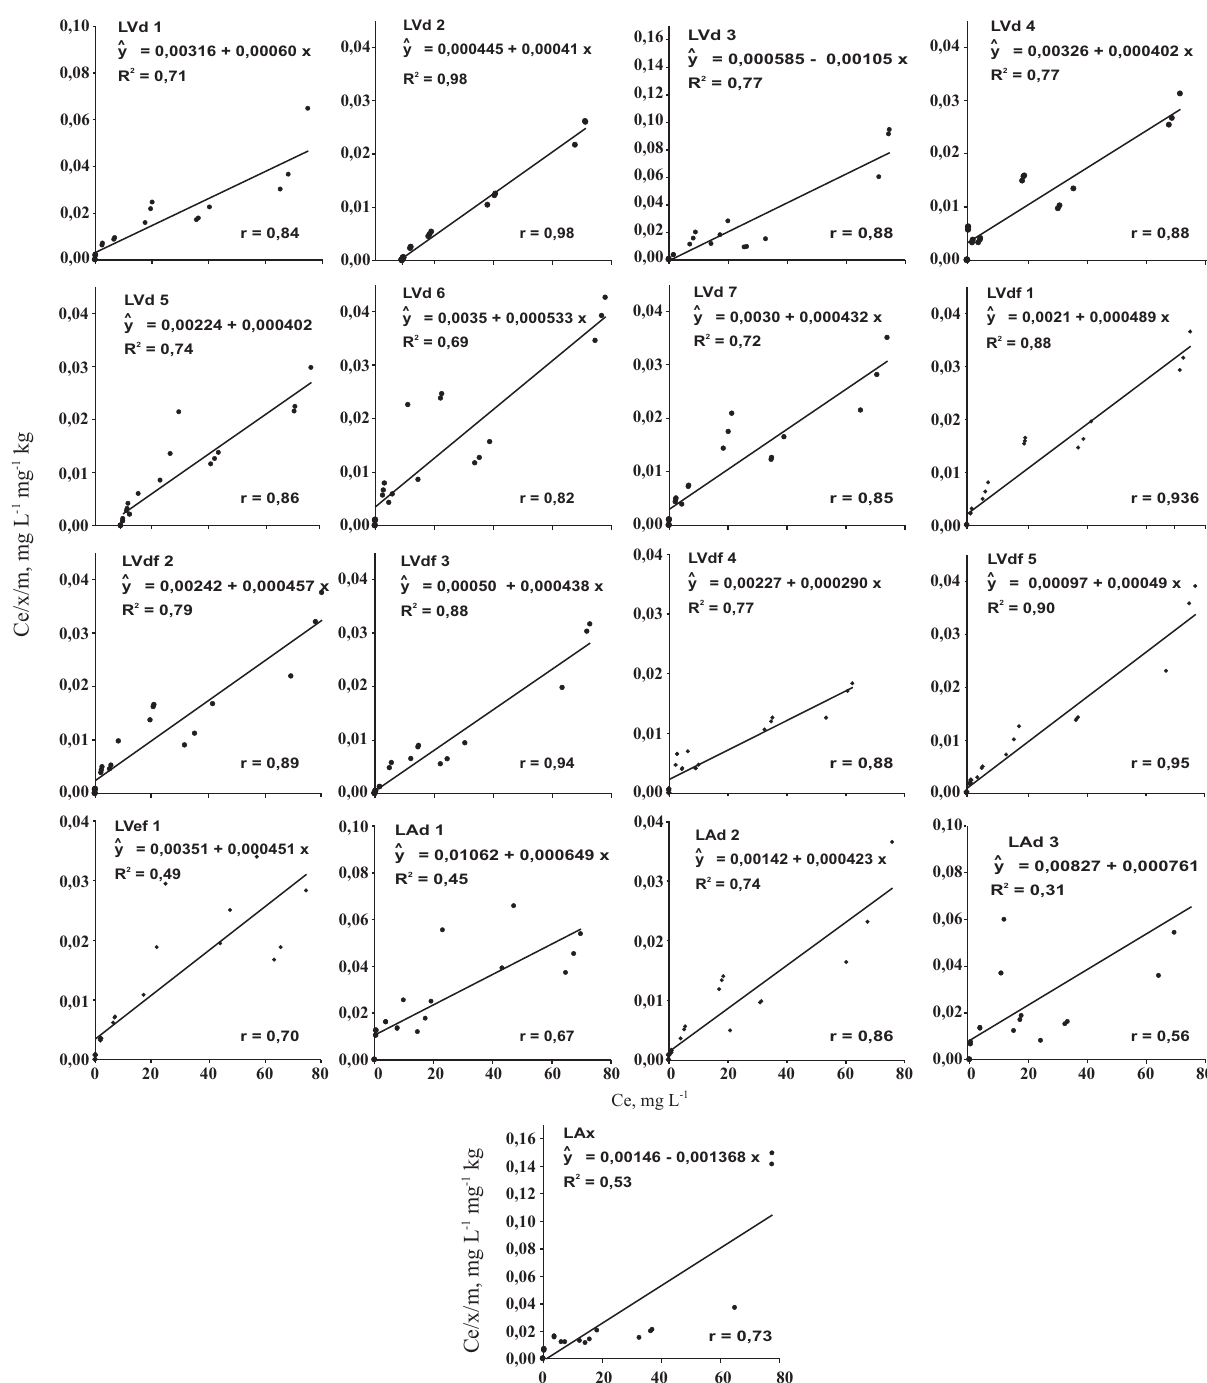
Figura 2. Regressões lineares utilizadas no cálculo da capacidade máxima de adsorção de As (CMADS amostras do horizonte A dos 17 Latossolos